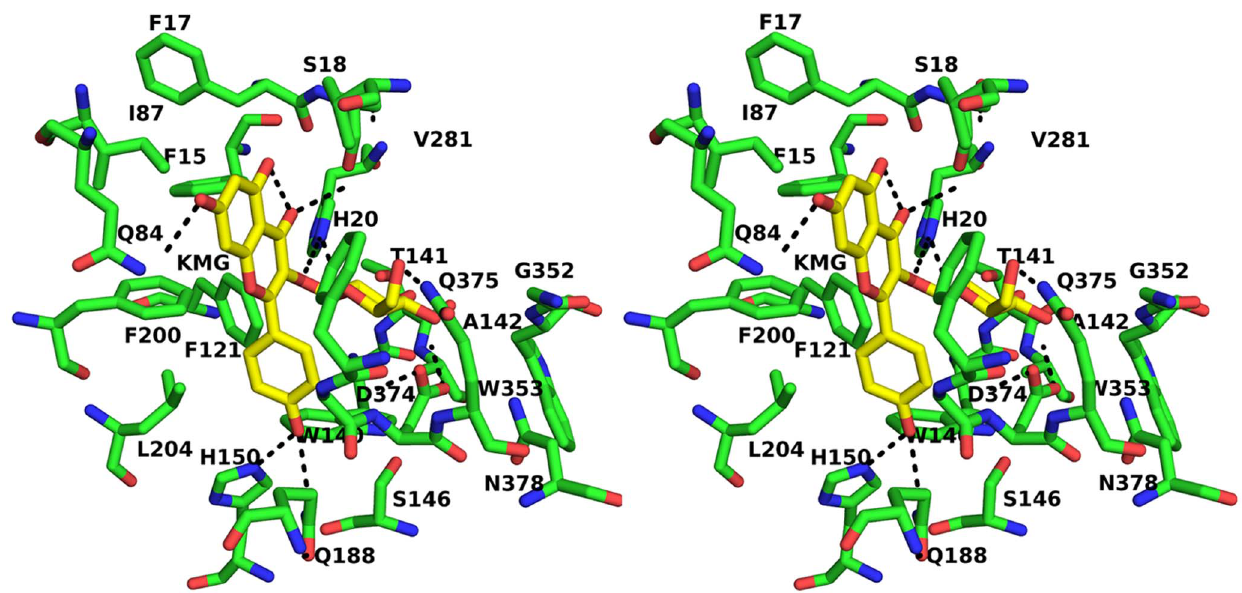
Figure 8. Kaempferol-3-O-glucoside interactions with the UGT. Stereo view of docked complex of UGT from F. ananassa with Kaempferol-3- O-glucoside shown in stick form.